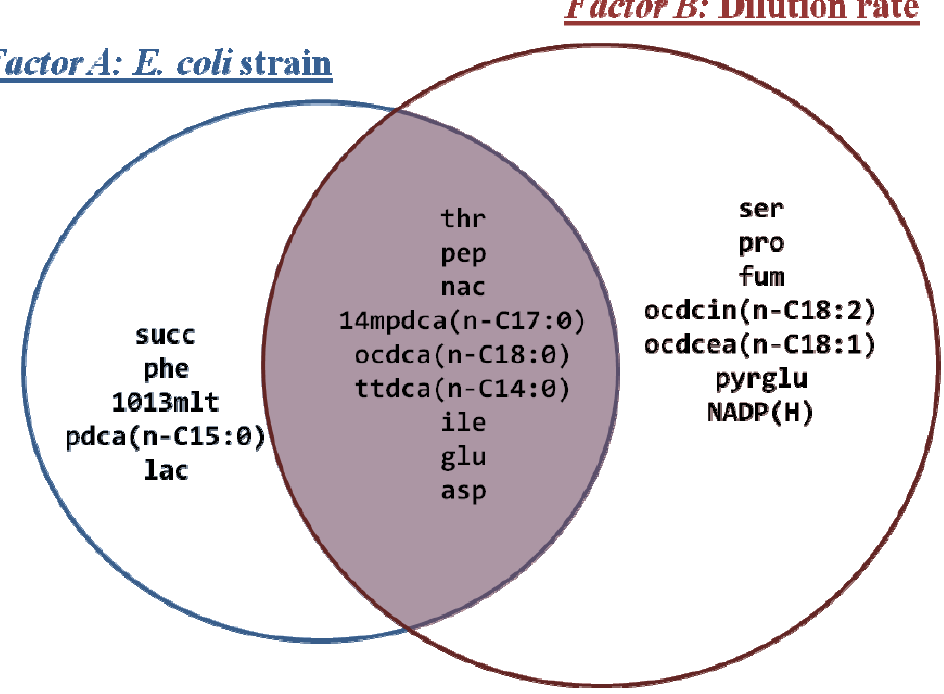
Figure 1. Venn diagram showing the list of the intracellular metabolites that were significantly changed (p-value < 0.01) according to either factors: A ( i.e. , E. coli strain) or B ( i.e. , dilution